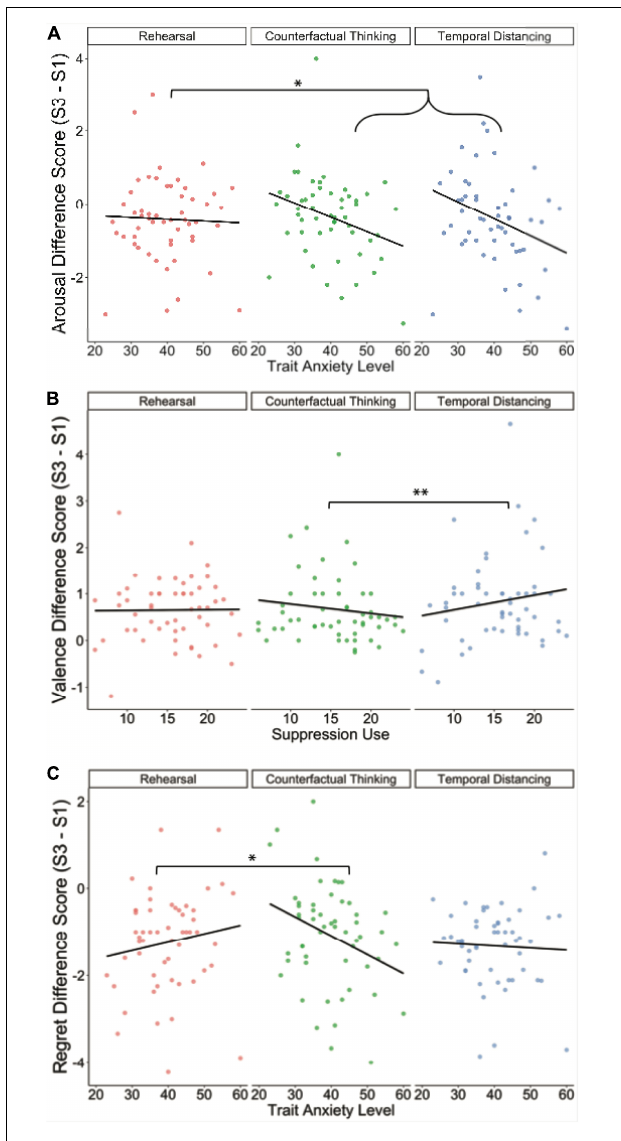
FIGURE 2 | Effects of individual difference measures on behavioral ratings. For ease of display, we have plotted average values per participant here, instead of individual memory values. (A) Change in subjective arousal across the experiment by regulation condition and trait anxiety. Higher-anxious individuals showed more arousal reduction in their memories after implementing both active regulation strategies than those with lower anxiety. (B) Valence ratings as a function of suppression usage. Compared to those who do not use suppression, participants with higher suppression usage benefited more from temporal distancing but benefited less from CFT in terms of negative valence reduction over time. (C) Regret ratings as a function of participants’ trait anxiety. Compared to low-anxious individuals, higher-anxious individuals showed a greater benefit in regret reduction over time following CFT than rehearsal. S1 = Session 1, S3 = Session 3, ∗ p < 0.05, ∗∗ p < 0.01.